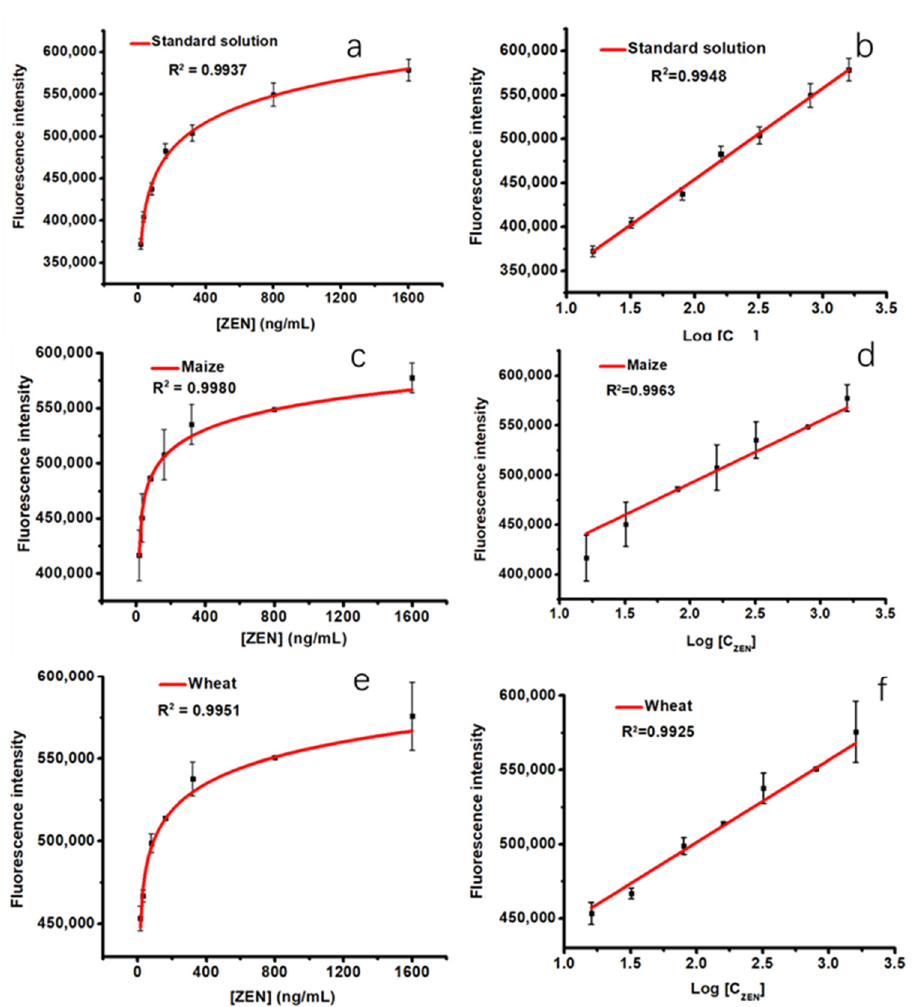
Figure 4. Curve fitting and calibration curves of the fluorescence intensity versus the various ZEN concentrations for the automated and high-throughput method (( a , b ), spiked ZEN in standard solution; ( c , d ), spiked ZEN in maize matrix extraction, and ( e , f ), spiked ZEN in wheat matrix extraction). Table 2. Recovery and relative standard deviations of spiked maize and wheat samples with various ZEN concentrations of three levels.